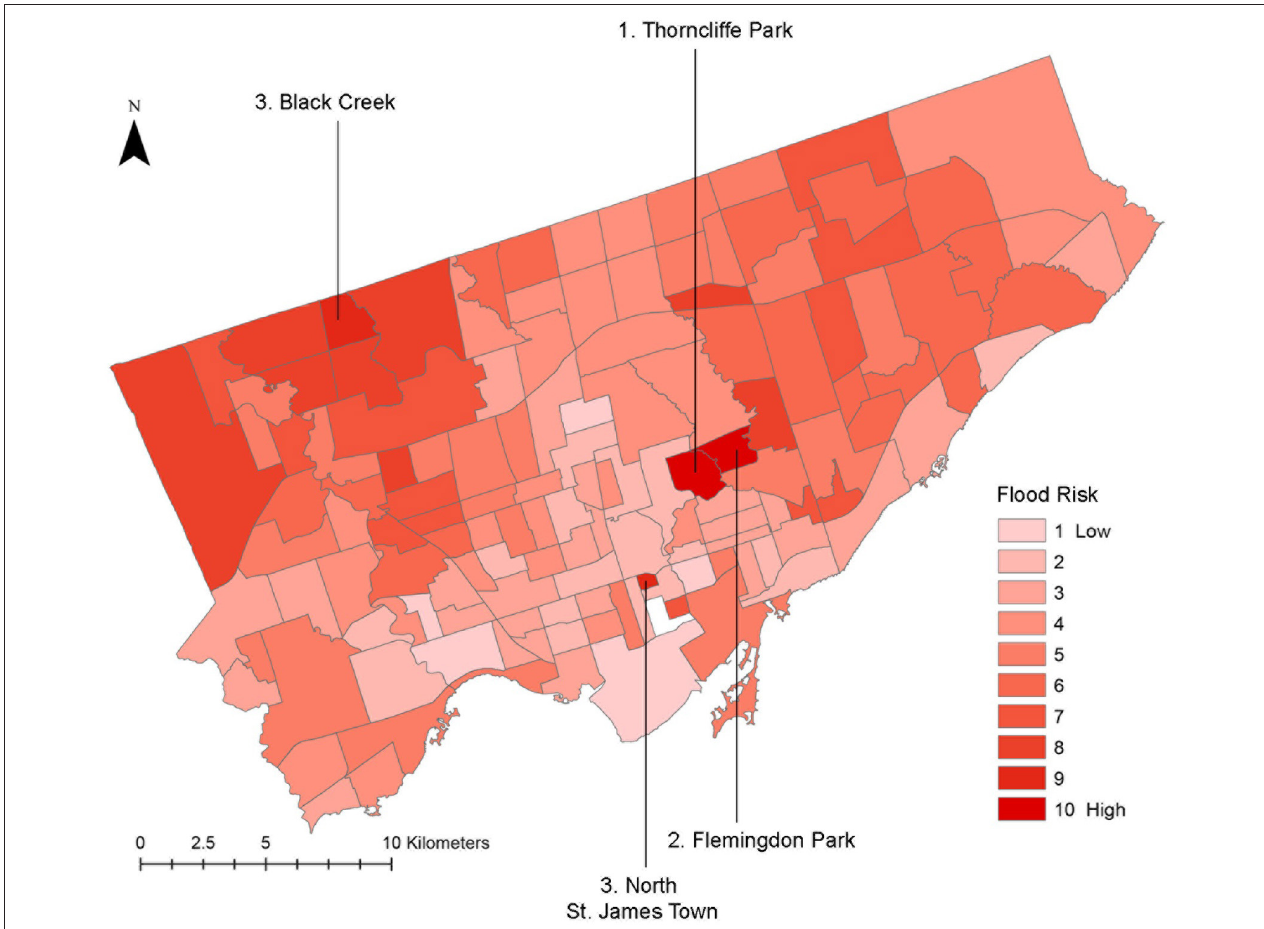
FIGURE 7 | The spatial distribution of flood risks and the priority neighborhoods for urban form adaptation in Toronto (the values are normalized from 1 to 10 when 1 shows low risks and 10 shows high risks).